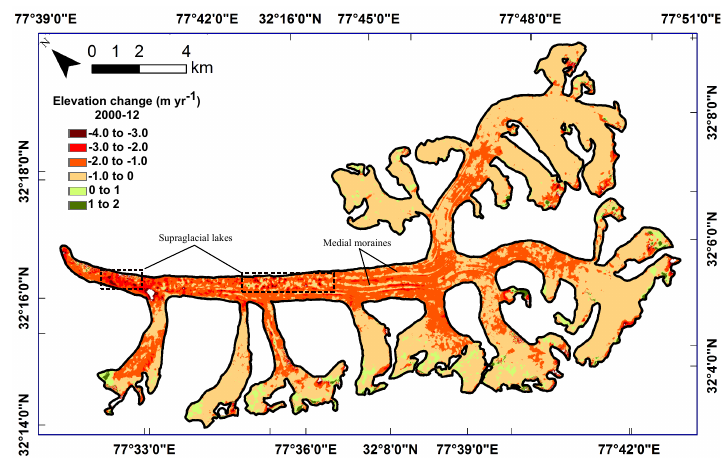
Figure 7. Elevation change map of Bara Shigri Glacier during 2000–2012. The location of few supraglacial lakes and medial moraines are